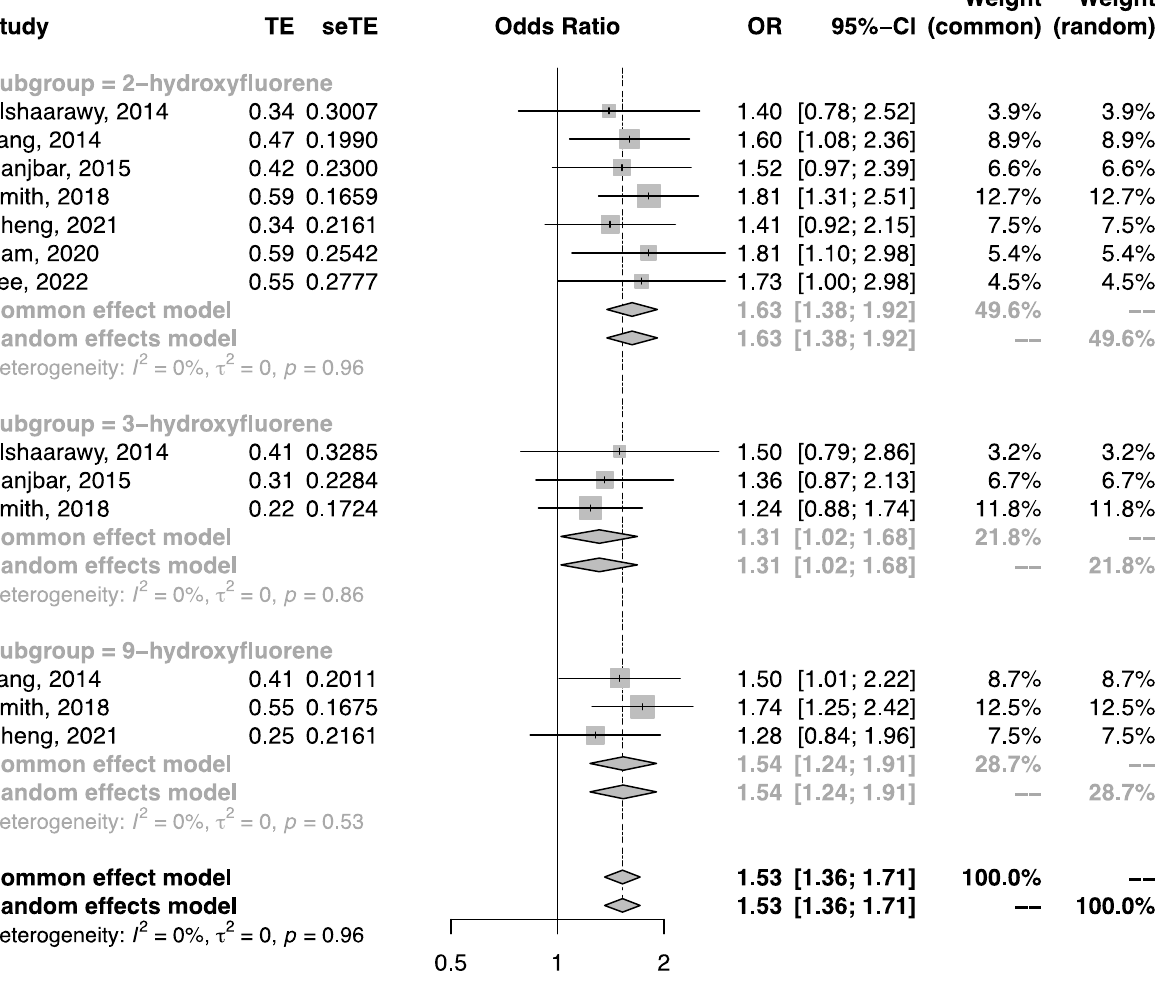
Figure 2. The association between urinary NAP metabolites and risk of T2DM [20–25,28].